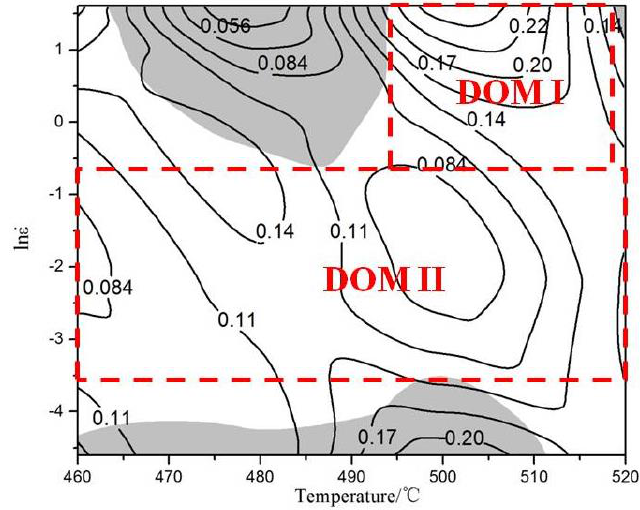
Figure 7. Processing maps of the dual-scale SiCp/A356 composites at the strain of 0.5.